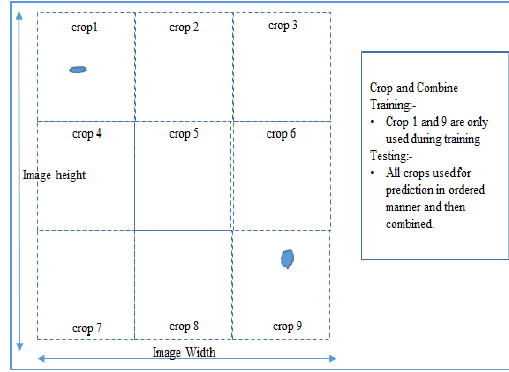
Figure 4 . Crop and Combine data augmentation